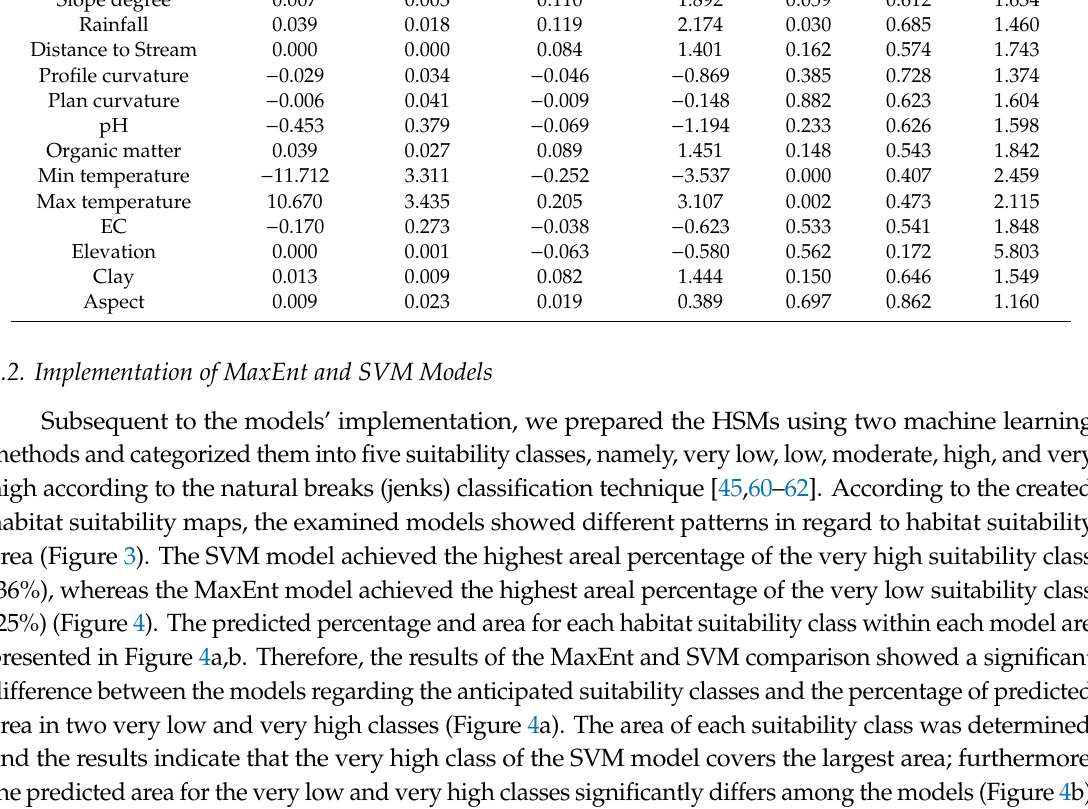
Figure 4. Percentages of different habitat suitability classes ( a ), and ( b ) predicated area for each class of habitat suitability. 3.3. Importance of Effective Factors We assessed the relative importance of the effective factors with the Jackknife variance estimation method for the area under the curve (AUC), and the analysis results are shown in Figure 5. According to the results of the relative importance test, the Max and Min temperature factors are deemed most important for HSM, followed by annual mean rainfall, distance from urban area, TWI, distance to streams, slope degree, clay percentage, organic matter, elevation, profile curvature, EC, aspect, plan curvature, and pH (Figure 5).